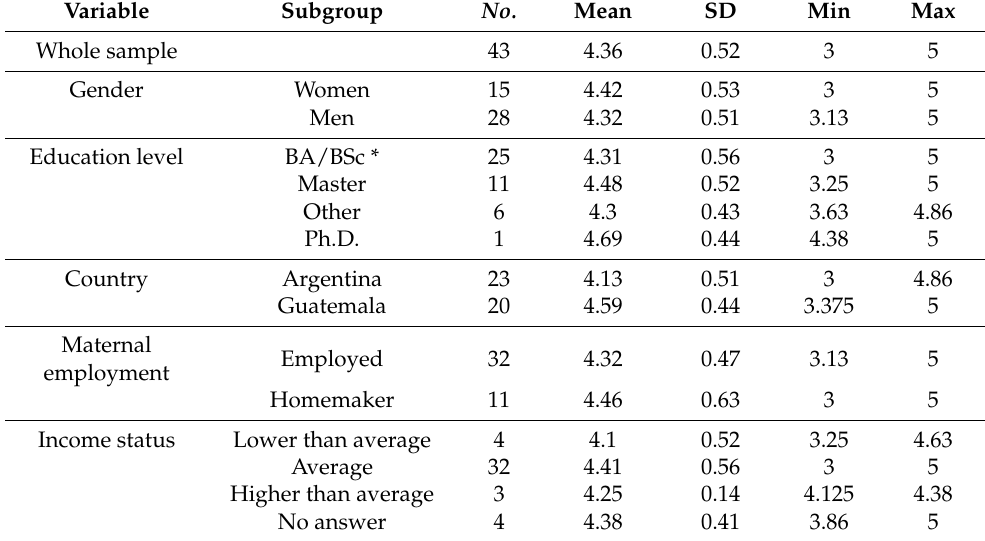
Table 2. Self-efficacy mean levels by group.